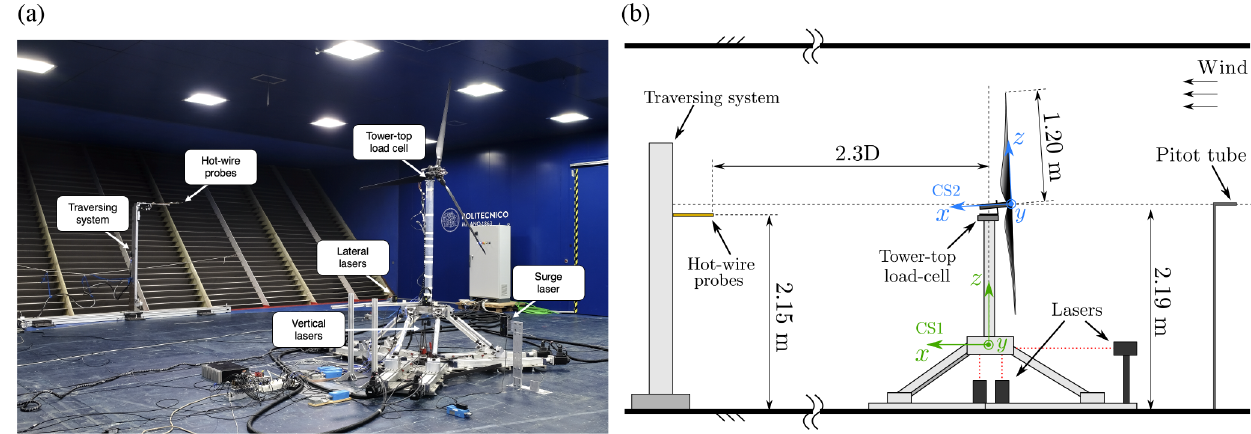
Figure 1. Experimental setup in the Polimi wind tunnel (a) and schematic of the test setup with the coordinate systems (CS) used for measurements and their analysis (b) .